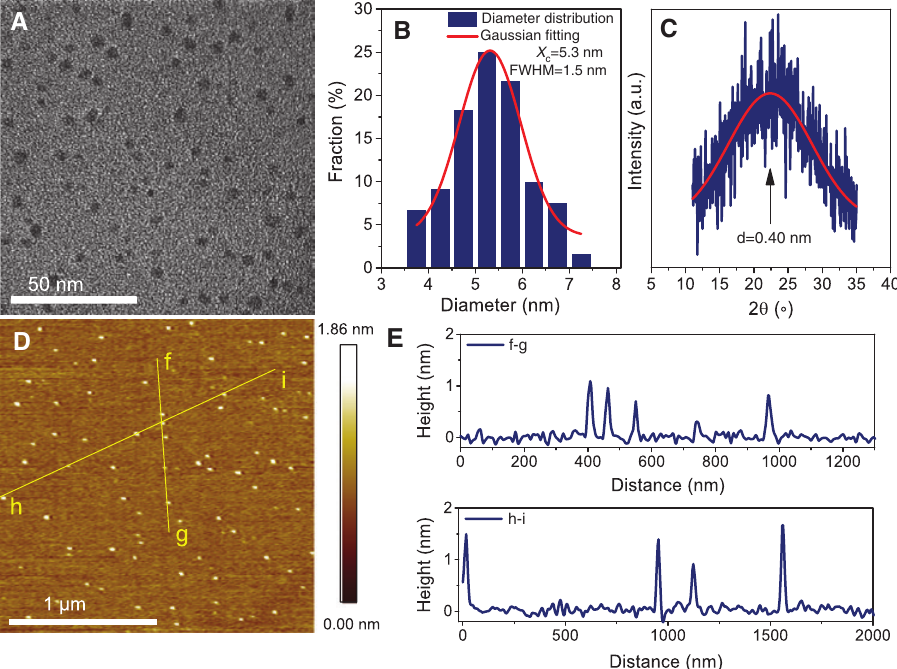
Figure 2: (A) TEM image of NGQDs assembled on a Cu grid coated with an ultrathin amorphous carbon film. (B) Diameter distribution of NGQDs. The red line is the Gaussian fitting curve. The average size ( X ) of NGQDs is 5.3 nm with an FWHM of 1.5 nm. (C) XRD pattern of c NGQDs. (D) AFM image of NGQDs on a mica substrate. (E) Height profile along the lines marked in (D).